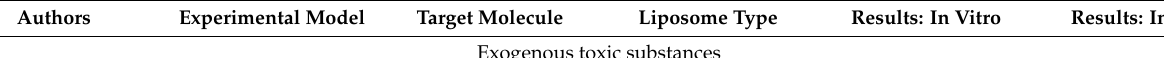
Table 1. Summary of studies included in the